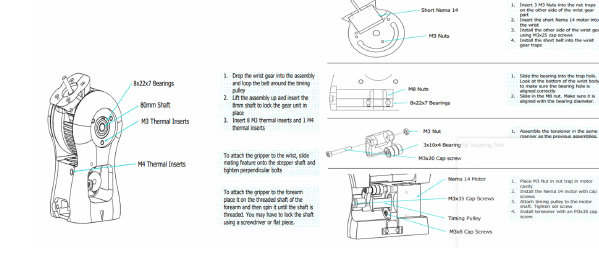
Fig. 6. Design for wrist assembly